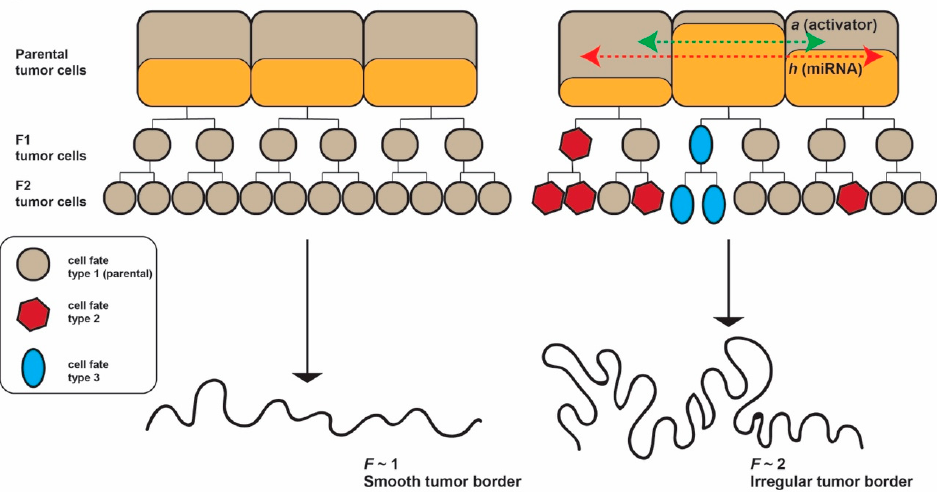
Figure 1. We hypothesize that miRNAs travel to neighboring cells and act as morphogenetic inhibitors in shaping the tumor border of epithelial cancers, and that the di ff usion coe ffi cient of miRNAs is probably a major factor influencing the invasion front configuration. Three di ff erent cell generations are represented: parental, F1 and F2. If the concertation of activator and inhibitor does not change in parental cells, the F1 and F2 cells preserve the same fate type and the tumor border is smooth. If the activator and inhibitor di ff use into neighboring parental cells, new cell fate types emerge and the tumor border becomes irregular. F = fractal